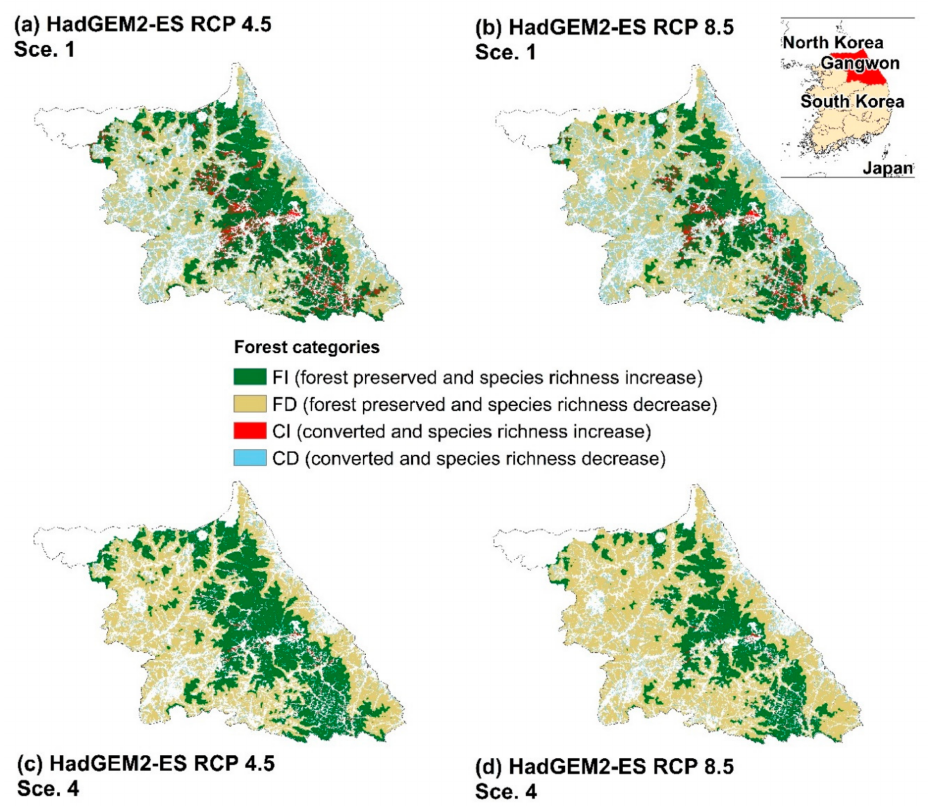
Figure 5. Distributions of four forest categories in four case maps. The maps in this figure represent Gangwon province, which contains future species-rich areas for many climate vulnerable species. We show two extreme forest conversion scenarios results (scenario 1: forest loss continues at current rates; scenario 4: conservation of forests in suitable future climates and the reduction of forest loss by 50%) using the HadGEM2-ES. Under RCP 4.5 (lower emission scenario), FI increased from 14.0% to 15.4% and CI decreased from 1.7% to 0.2% under scenario 4. Under RCP 8.5 (higher emission scenario), FI increased from 8.6% to 9.5% and CI decreased from 1.0% to 0.1% under scenario